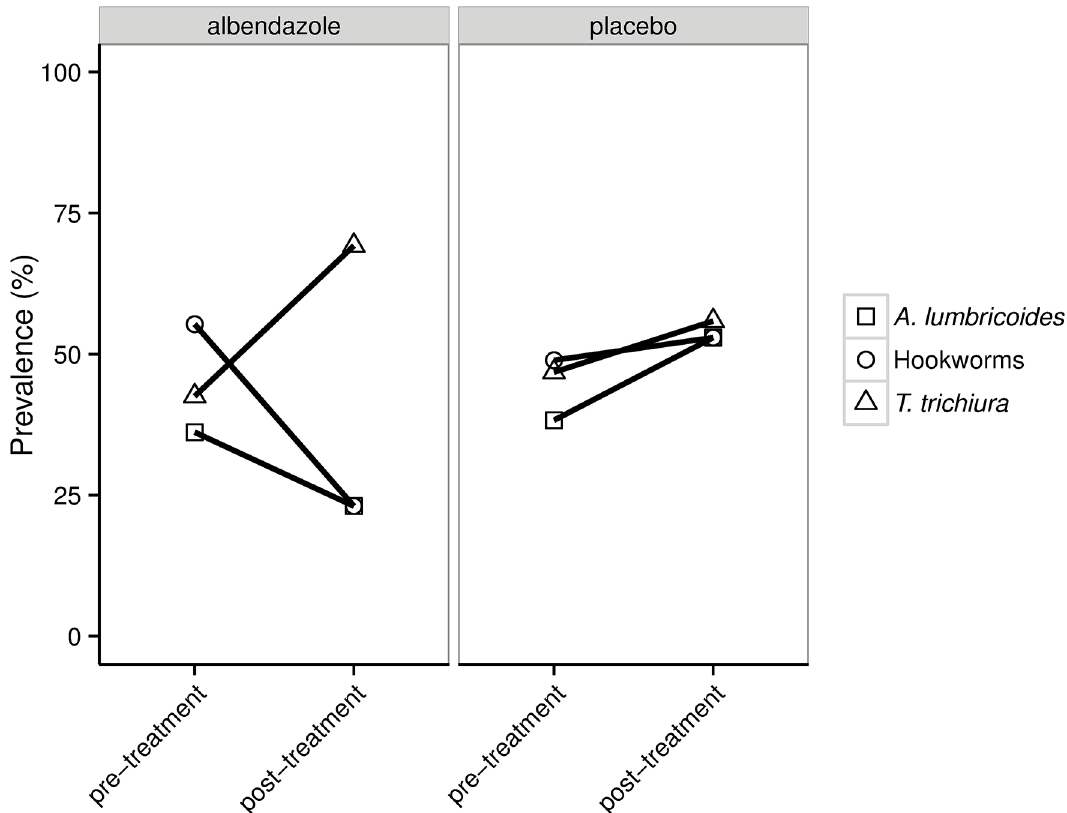
Fig 2. The prevalence of helminth coinfections in two randomization arms for subjects who were infected at pre-treatment and remained infected at post-treatment. For each helminth species depicted in the plot, square represents the percentage of subjects infected with A . lumbricoides (with or without other helminth species), circle represents hookworm (with or without other helminths) and triangle represents T . trichiura (with or without other